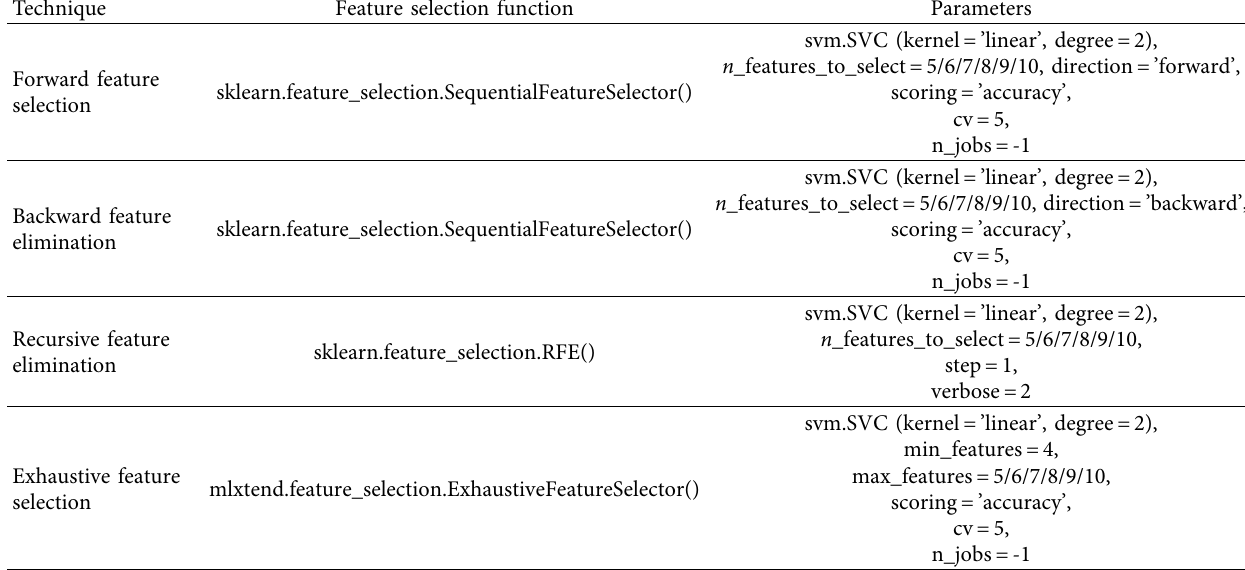
Table 3: Parameter settings for wrapper-based